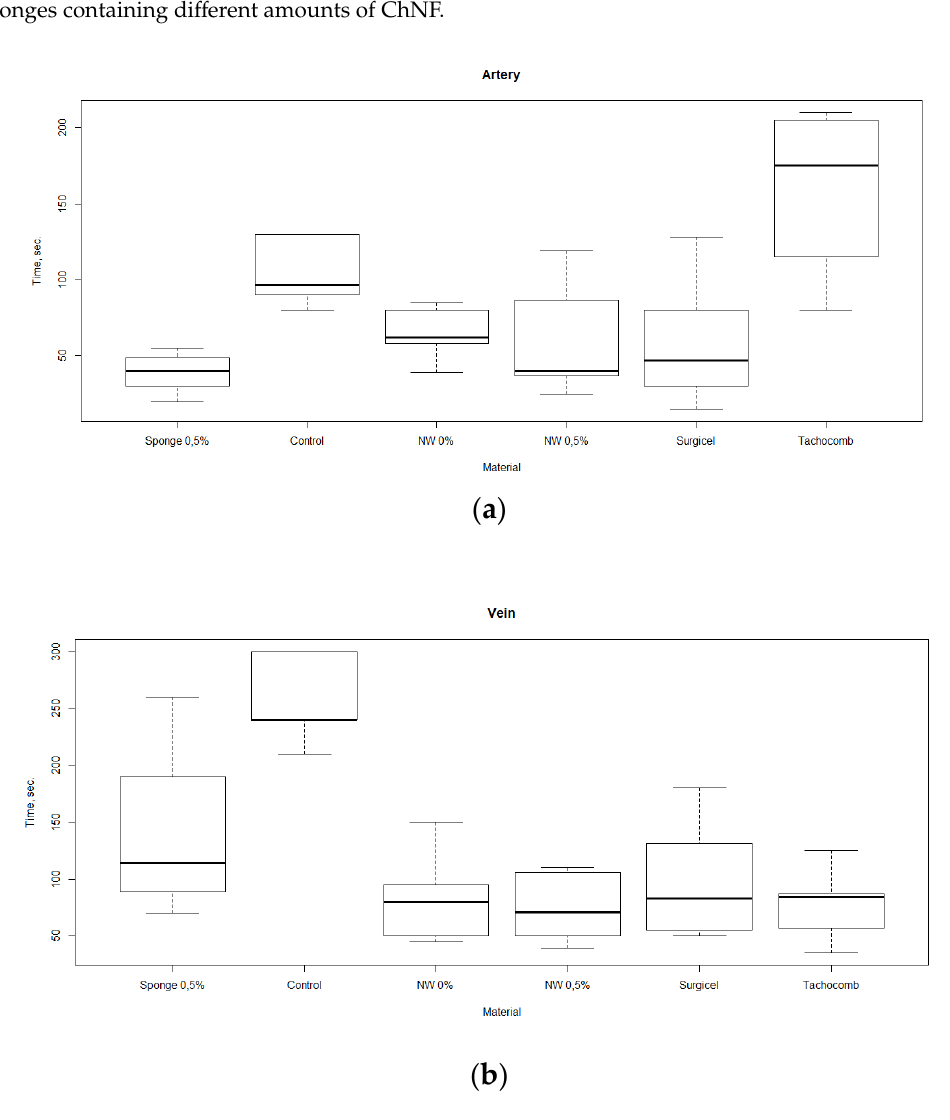
Figure 4. Rates of bleeding arrest (time until cessation of bleeding) in the experiments with different materials, in which femoral ( a ) and vein ( b ) artery hemorrhages were modeled.